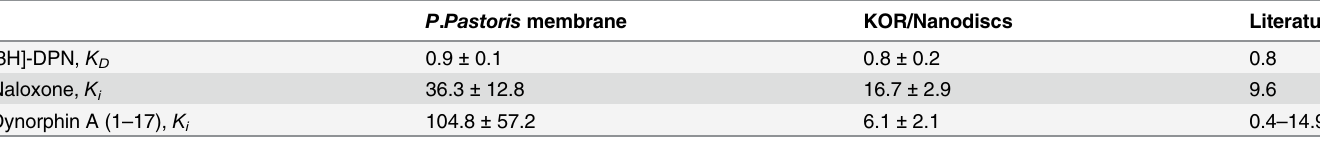
Table 2. Comparison of binding affinities ( K D , K i ) of KOR in P . pastoris membranes or in